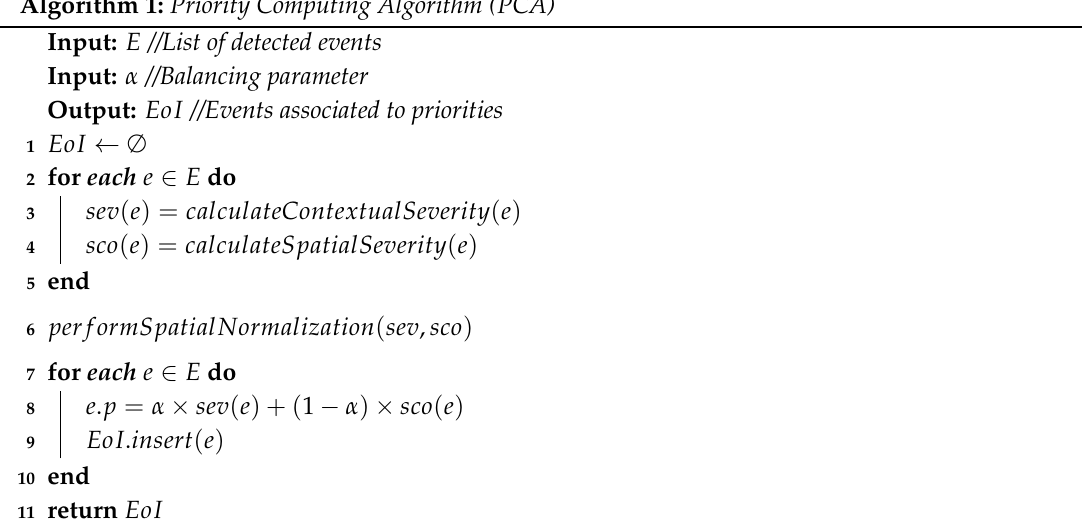
Algorithm 1: Priority Computing Algorithm